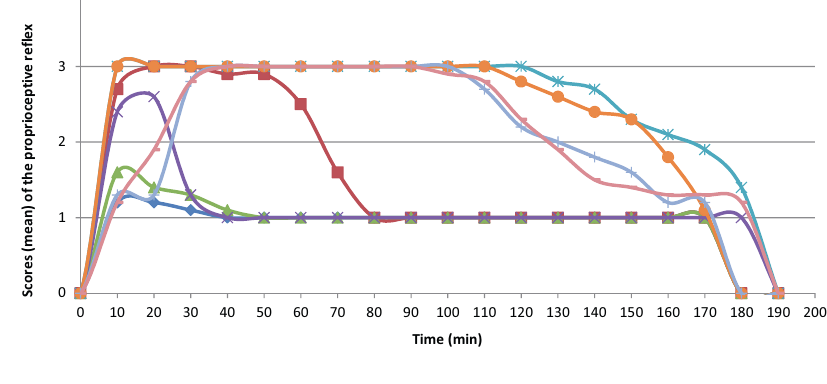
Figure 5 - Values of the proprioceptive reflex. (0) normal function, (1) slightly impaired, (2) severely impaired, (3) absent